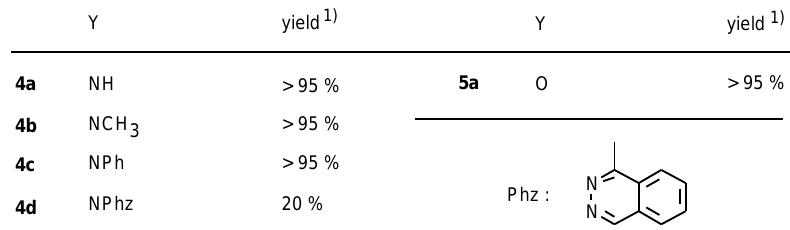
Table 4. Formation of pyrazoles